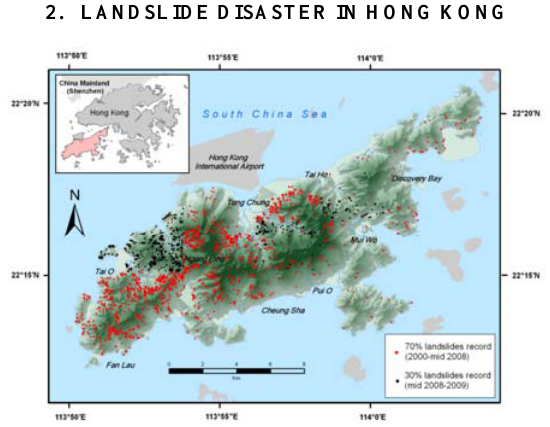
Figure 1. Study area and landslide